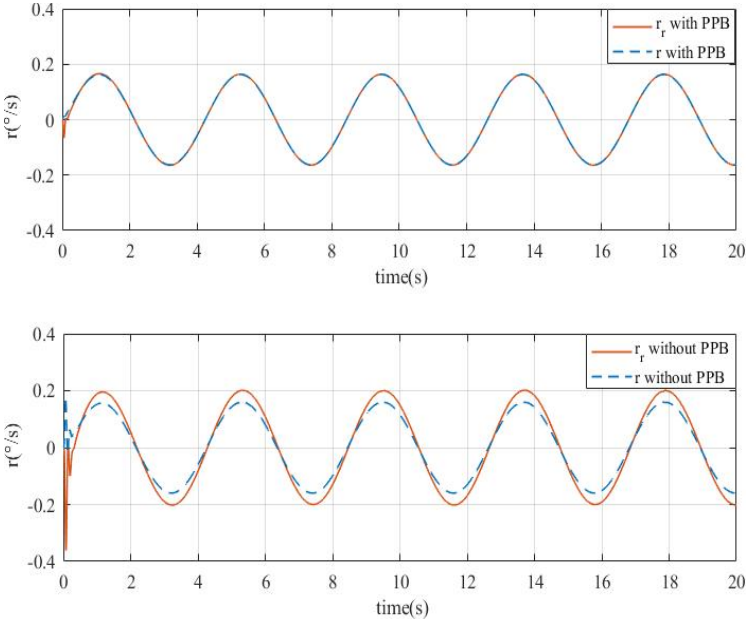
Figure 9. Tracking response of r .